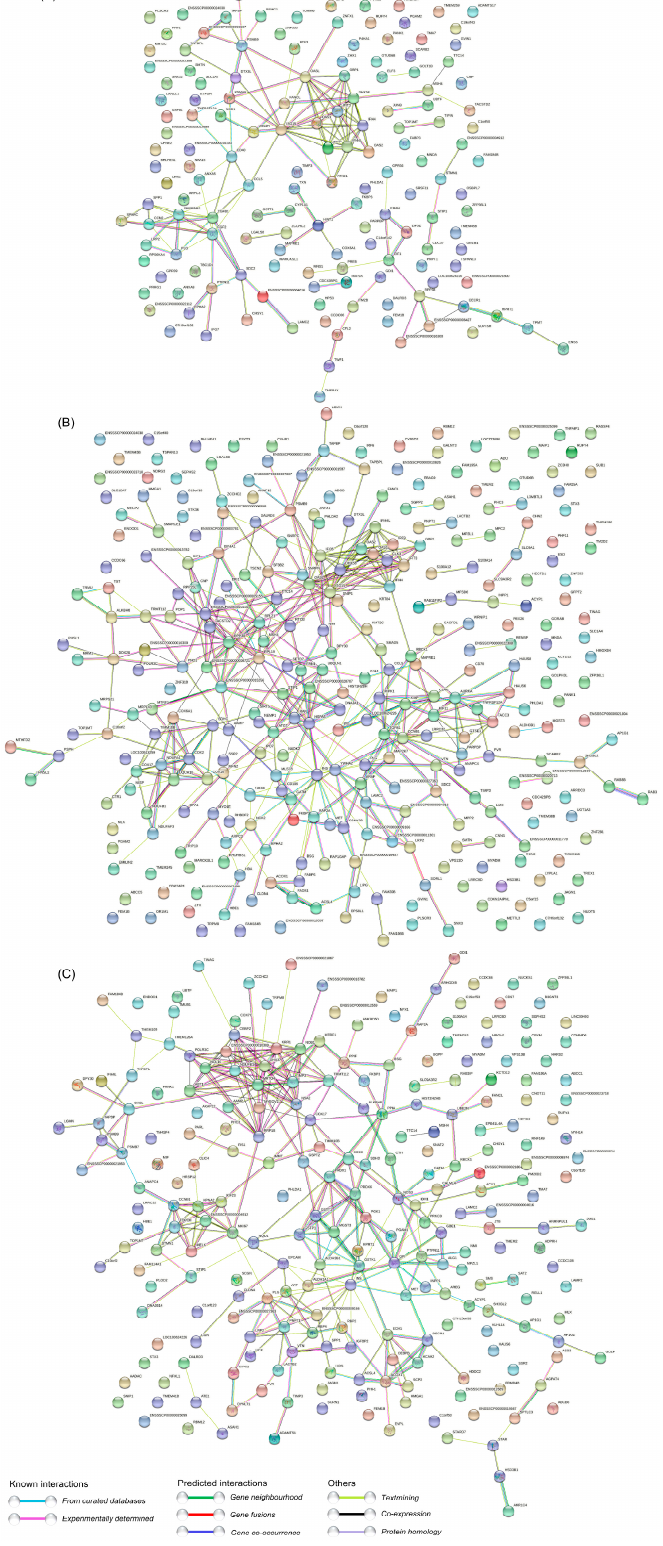
Figure 6. Protein–protein interaction (PPI) networks of the DEPs identified in PK-15 cells during SVA infection. ( A ) PPI networks of the DEPs at 12 hpi. ( B ) PPI networks of the DEPs at 24 hpi. ( C ) PPI